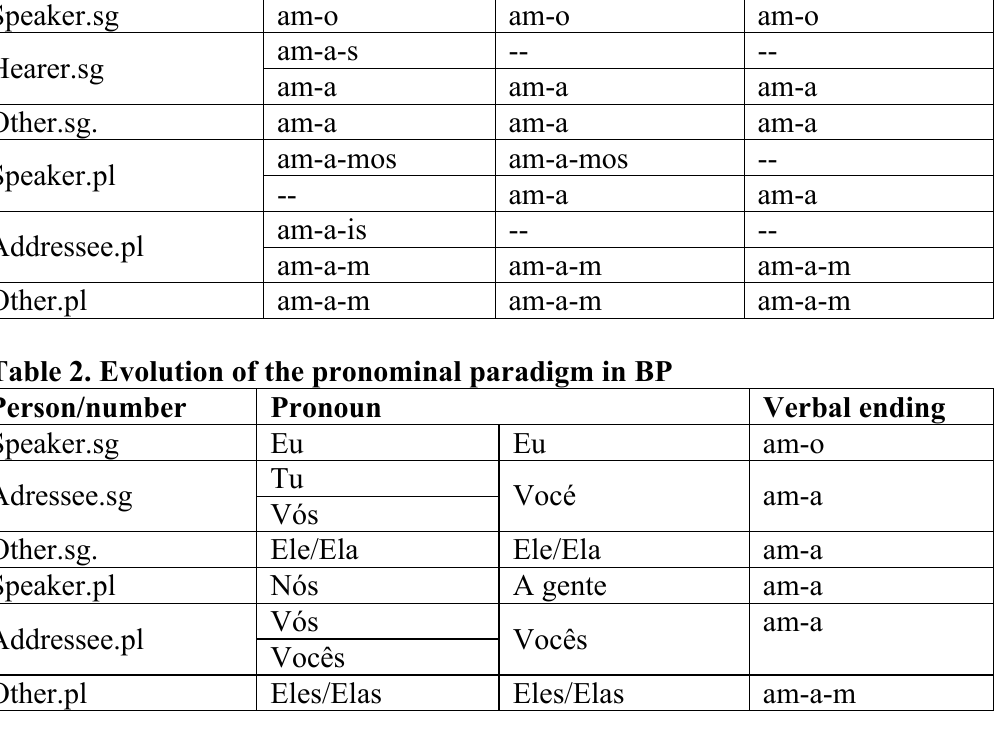
Table 1. Evolution of inflectional paradigms in BP Person/number